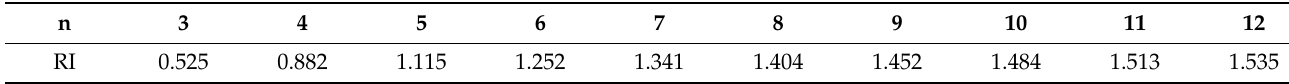
Table 3. The values of the RI corresponding to a variety of n .